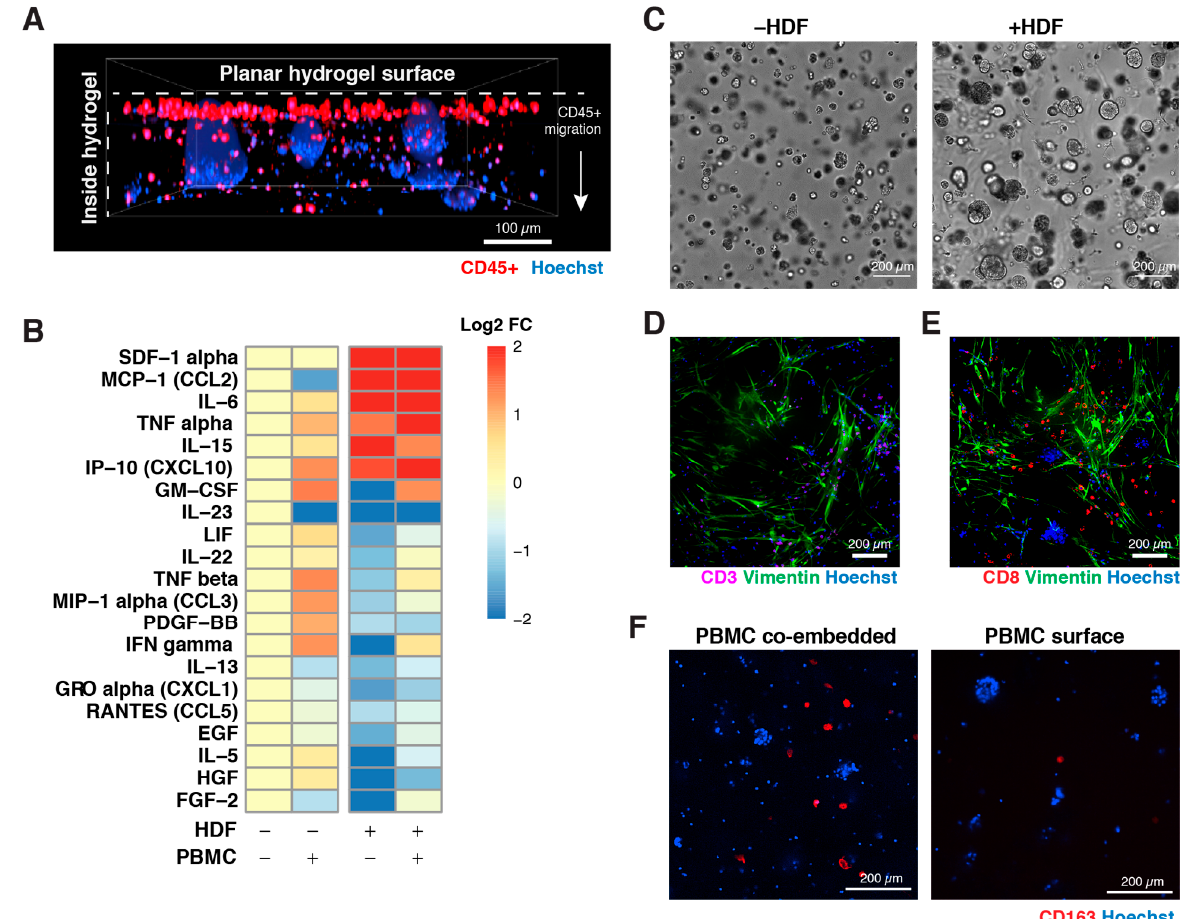
Figure 2. Three-dimensional hydrogel tumor model characterization: ( A ) Immunofluorescence image of a 3D tumor model of CXF1104 with CD45+ cells from PBMCs on the surface of, and infiltrating into, the hydrogel, demonstrating the hydrogel planarity. ( B ) Cytokine analysis comparing key pro-inflammatory markers across the various conditions—with or without HDF, and with or without PBMCs in 3D culture. ( C ) Growth optimization brightfield images of GXA 3067 model without and with HDF in the hydrogel. IF staining for ( D ) CD3 and ( E ) CD8 with vimentin to stain fibroblasts and Hoechst to stain nuclei, and ( F ) CD163 to stain M2 macrophages at endpoint following two 3D model setups—PBMCs co-embedded with tumor and fibroblasts in the hydrogel, and PBMCs seeded on top of the hydrogel surface.